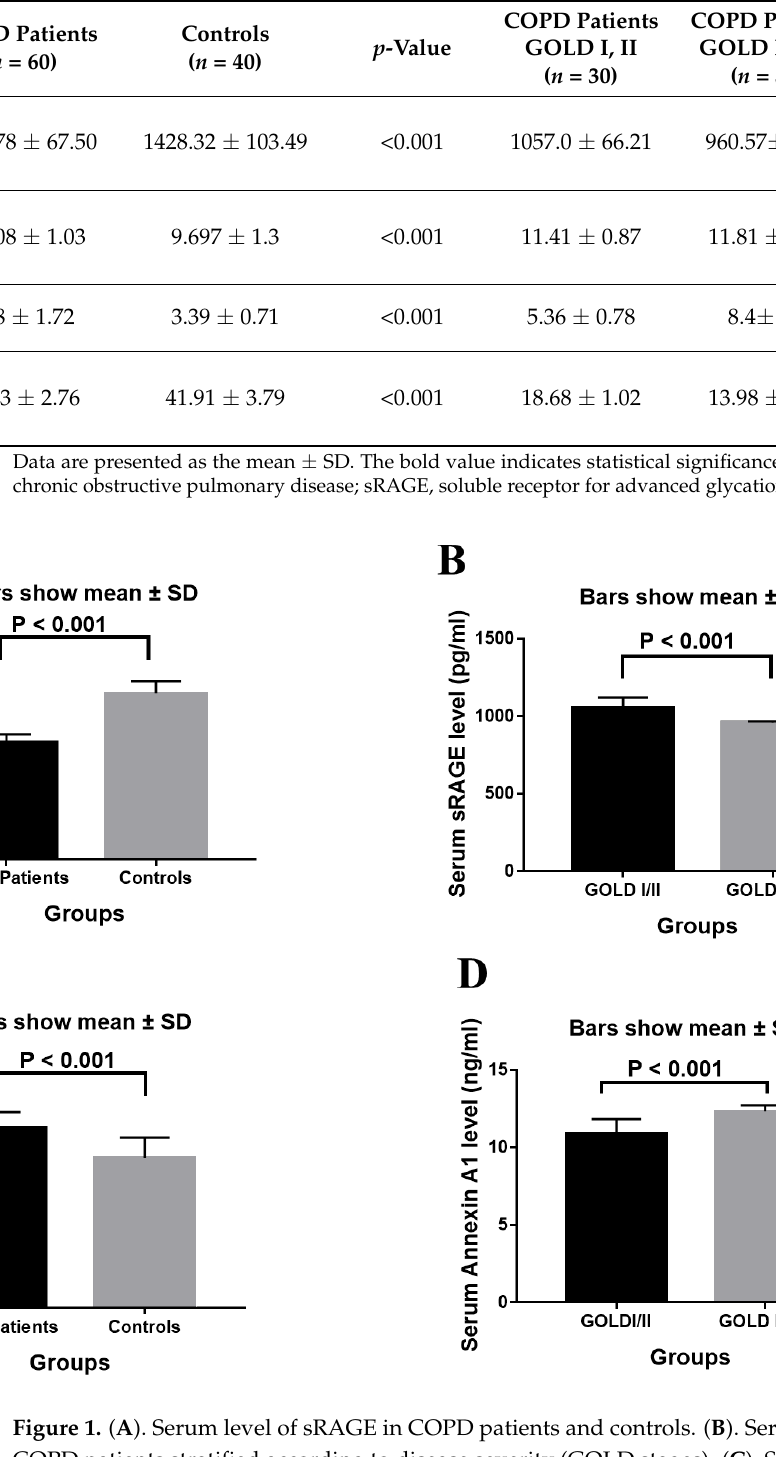
Table 5. Serum levels of sRAGE, annexin A1, MDA and GSH in COPD patients and controls. COPD Patients Controls p -Value GOLD I, II ( n = 60) ( n = 40)